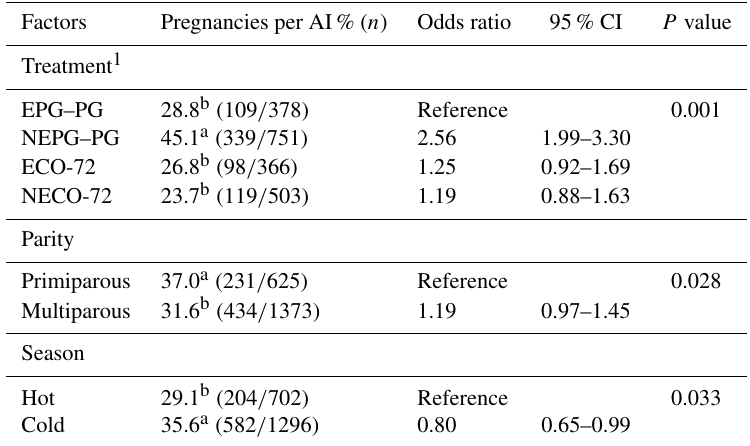
Table 3. Odds ratios of the variables included in the final logistic regression model for factors affecting pregnancies per AI on Day 47 ± 3